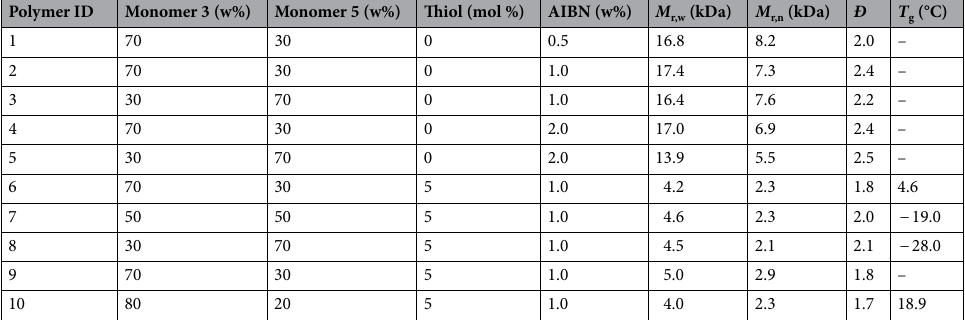
Table 2. Copolymerisation screen of trans -sobrerol acrylate (3) and oleic acid acrylate (5). Monomer ratios shown are the ones that were measured out at the start of each reaction. M r,w , M r,n —relative weight and number average molar masses (relative to poly(methyl methacrylate) standards) from gel permetation chromatography. Đ = M r,w / M r,n . T g glass transition temperature (from DSC); w% mass or “weight”